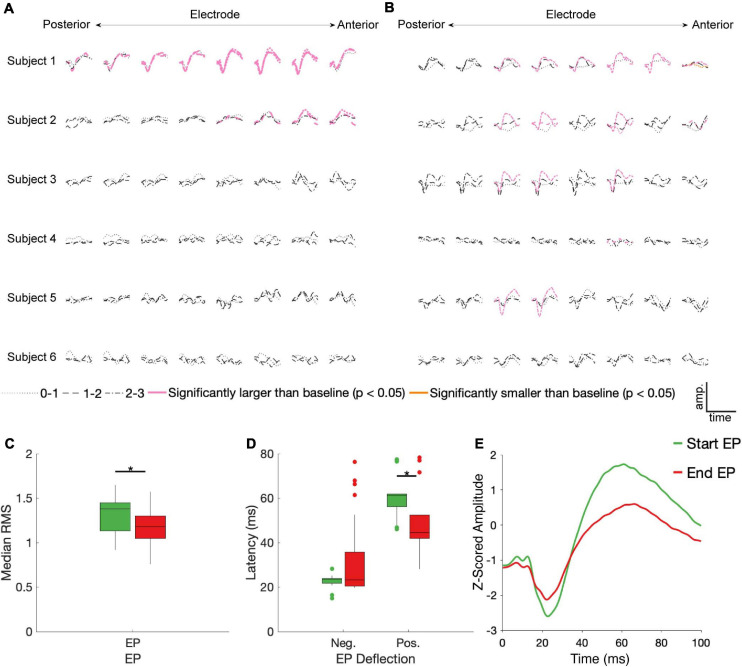
STN DBS evokes start and end EPs. Z-scored start (A) and end (B) EPs (average of 30 trials) are shown for each electrode (columns, contacts were in different BAs for each subject – see Figure 1), subject (rows), and DBS stimulation electrode pair (line type). EPs in pink had a statistically significantly larger magnitude than baseline deviations (p < 0.05, FDR corrected by subject). The one trace in yellow was also statistically different than baseline, but it had a lower magnitude. Median RMS (C) and latencies to negative and positive deflections on the average traces (D) were compared between the start and end EPs; significant (p < 0.05, FDR corrected) differences indicated by stars. (E) The average of all significant start (green) and end (red) EPs.